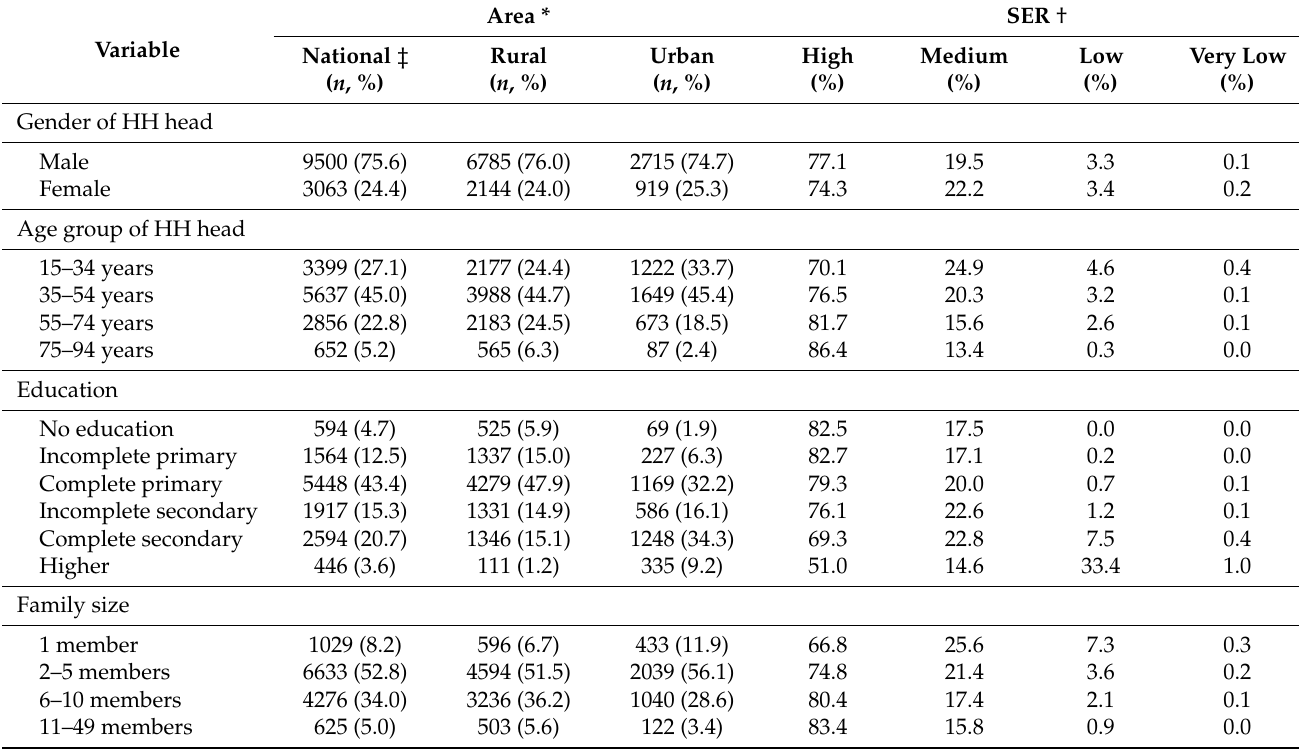
Rural Urban Figure 1. Cluster–level prevalence of average household smoke-exposure risk by survey zone in Tanzania. Each dot represents the average household smoke-exposure Risk (SER) value of the cluster, with each cluster representing the average SER of 20–22 included households. Please refer to the Sections 2.2. and 2.3. for details. Table 2. Sociodemographic and economic characteristics by zone and household smoke-exposure risk (SER) categories in